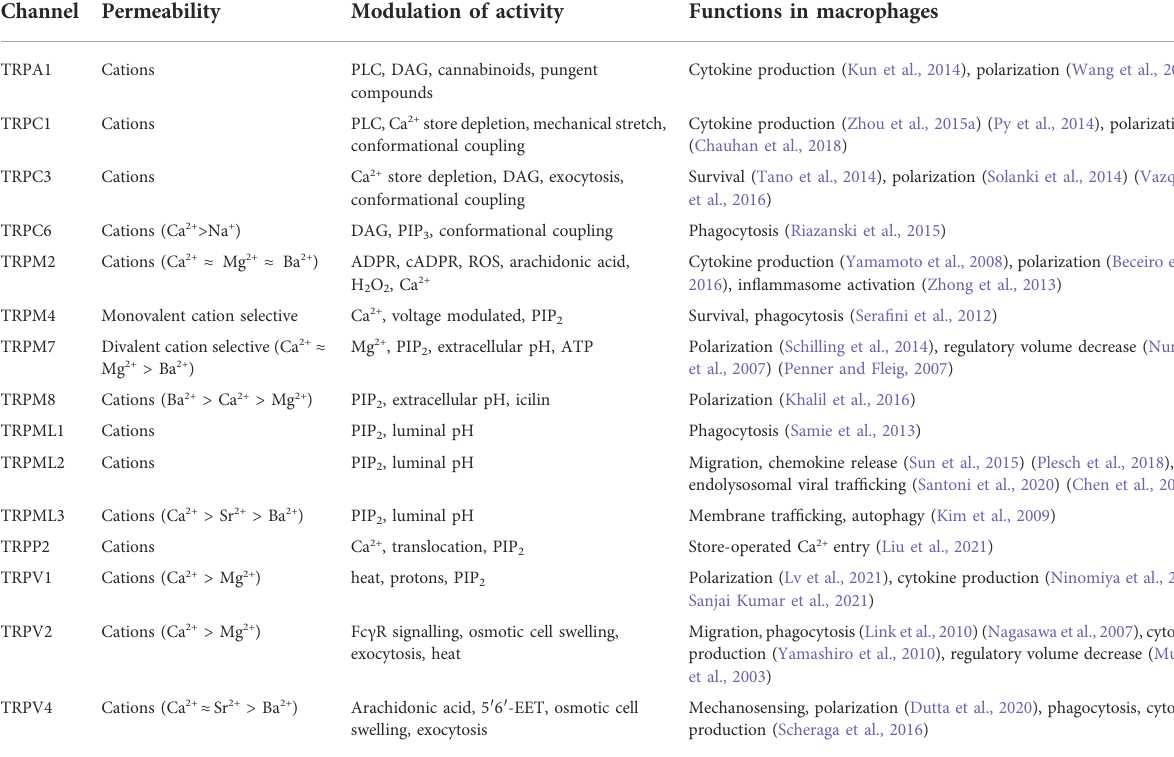
TABLE 3 A summary of Transient Receptor Potential (TRP) ion channels identi fi ed in macrophages to date. Channel